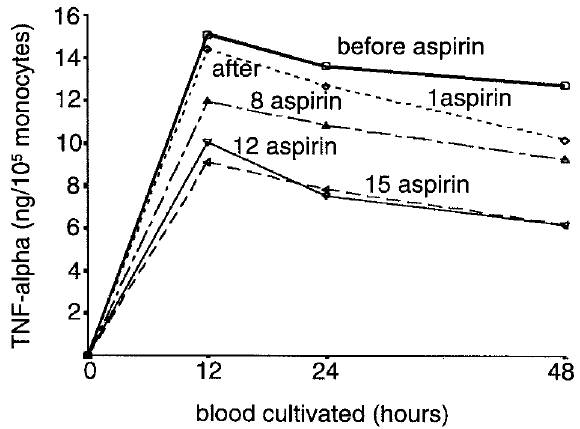
FIG. 4. The effect of a daily intake of 80mg aspirin on the release of tumor necrosis factor- a (TNF- a ) from lipopoly- saccharide (LPS)-stimulated blood cultures from a healthy woman. Subject 9 ingested 80mg aspirin for 15 consecutive days. Blood was sampled immediately before aspirin intake (day 1) and on days 2, 9, 13 and 16. An automatic differential leukocyte count (Cysmex NE 8000) was performed in all blood samples. LPS-stimulated blood cultures were pre- pared, and TNF- a concentrations in blood culture super- natants measured by a Biosource enzyme immunoassay using three monoclonal antibodies for TNF- a detection and calculated as nanograms per 10 5 monocytes.